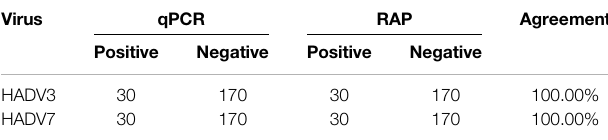
TABLE 3 | Detection of HADV3 and HADV7 in clinical